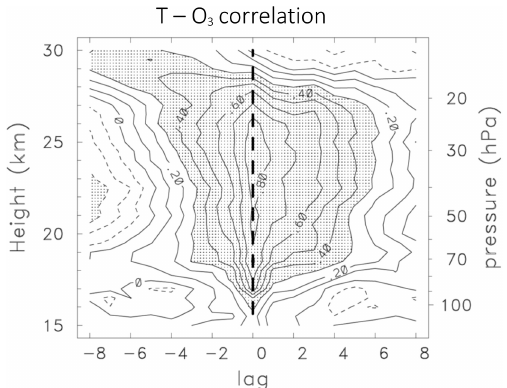
Figure 4. Correlation of deseasonalized SHADOZ ozone and tem- perature time series as a function of height and time lag (in months). Positive lag denotes temperature leading ozone.